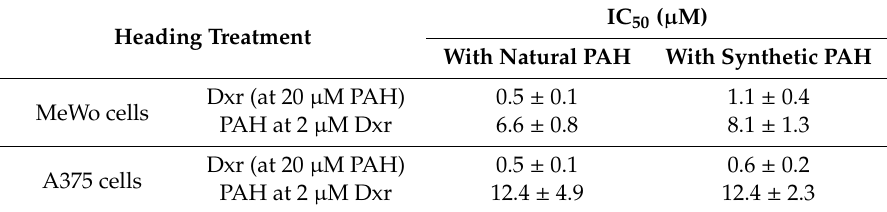
Table 2. Synthetic PAH is as e ff ective as natural PAH to increase dxr cytotoxicity against melanoma cells. IC 50 values were calculated using GraphPad Prism 6 software. Mean ± SEM of 3 independent experiments are